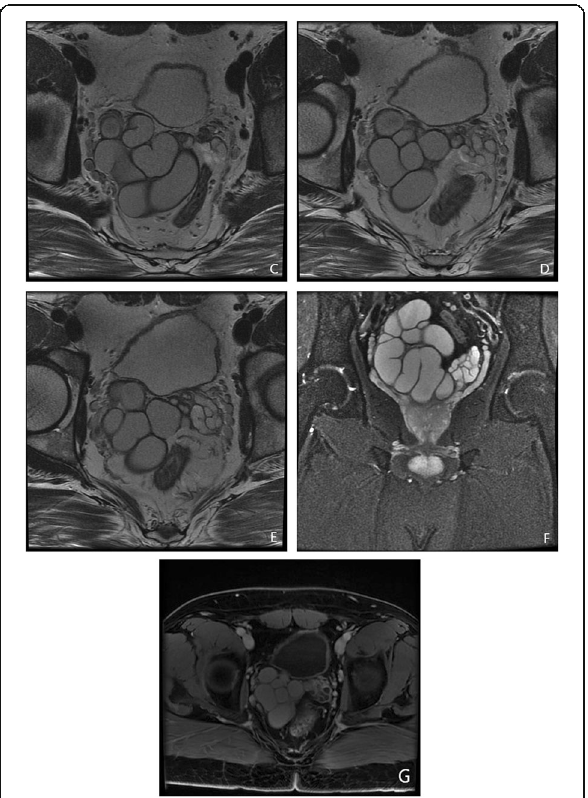
Fig. 3 MRI images — axial T2 WIs ( c – e ), coronal T2 FS WIs ( f ), and post-contrast T1 fat sat axial image ( g ) showing a lobulated tubular fluid-filled cystic lesion replacing the right seminal vesicle with no contrast enhancement in the post-contrast images seen exerting mass effect upon the surrounding structures, while the left vesicle and prostate are seen of normal MRI